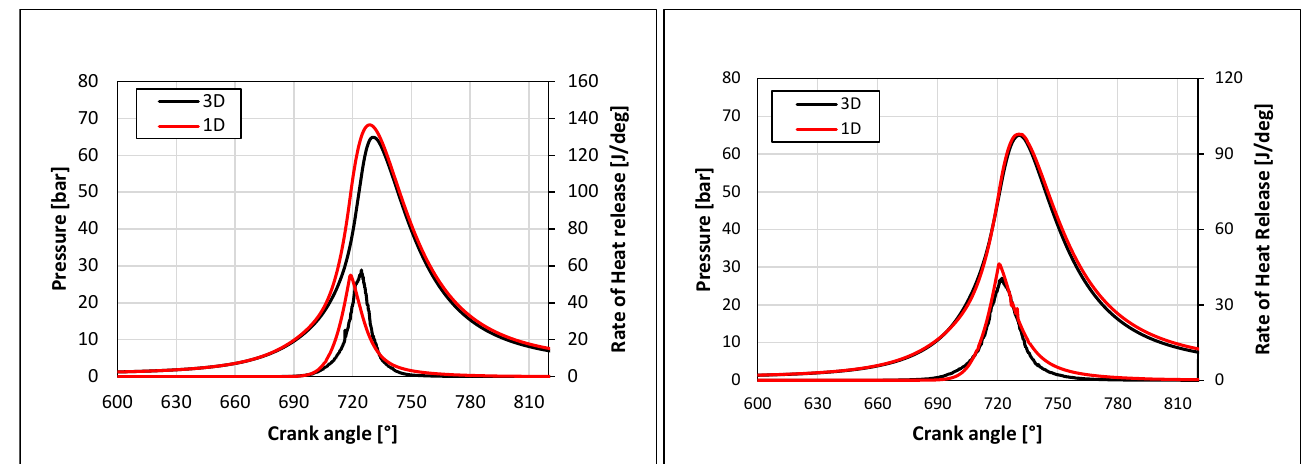
Figure 4. In-cylinder pressure and rate of heat release. The 1500 ( left )–3000 ( right ) rpm, no boost, WOT.